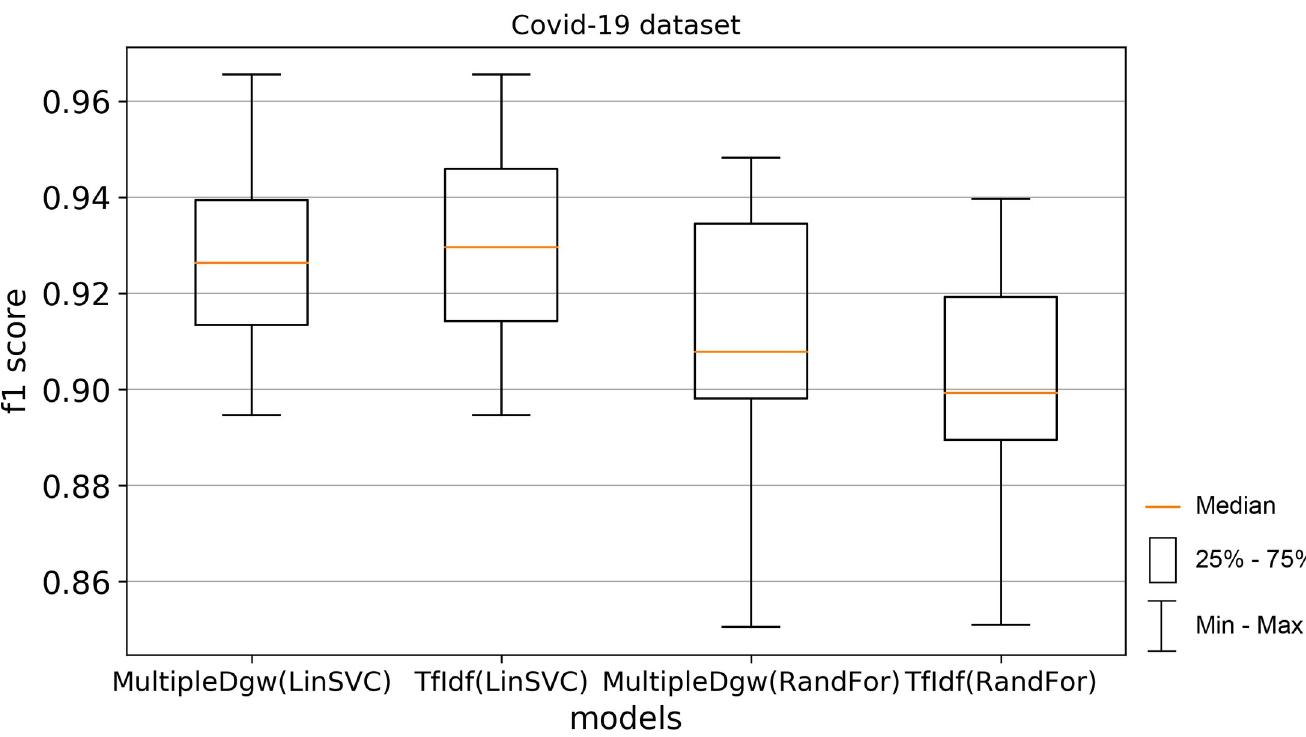
Fig 12. Boxplot for the model performance measurement - f1-score for dataset Covid-19.